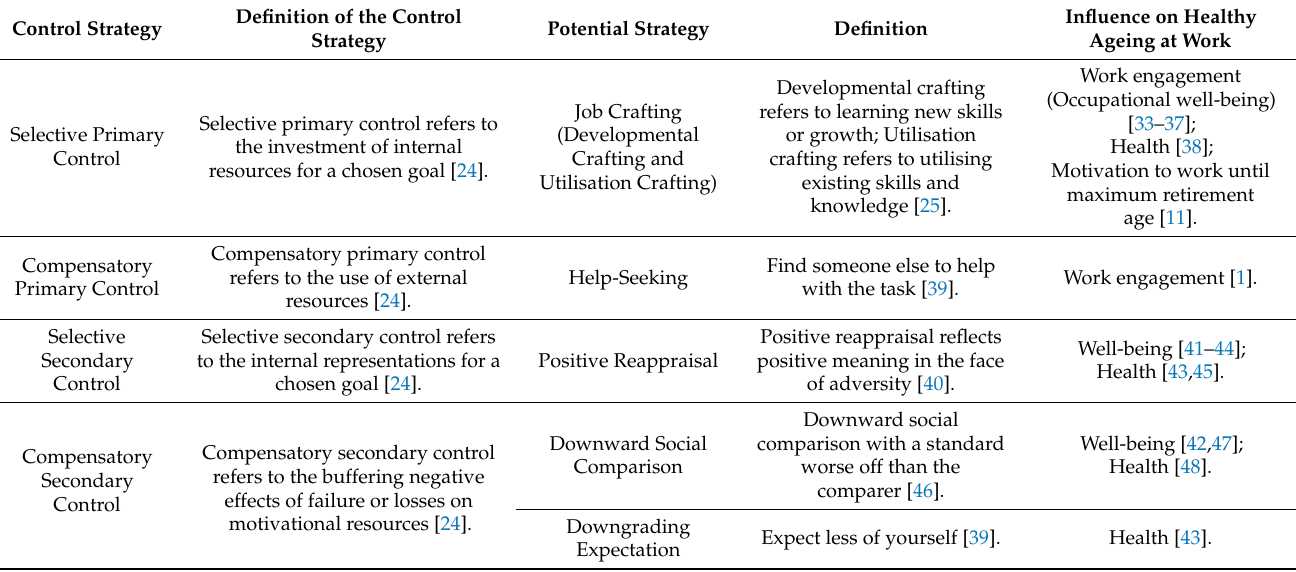
Table 1. Potential strategies that influence healthy ageing at